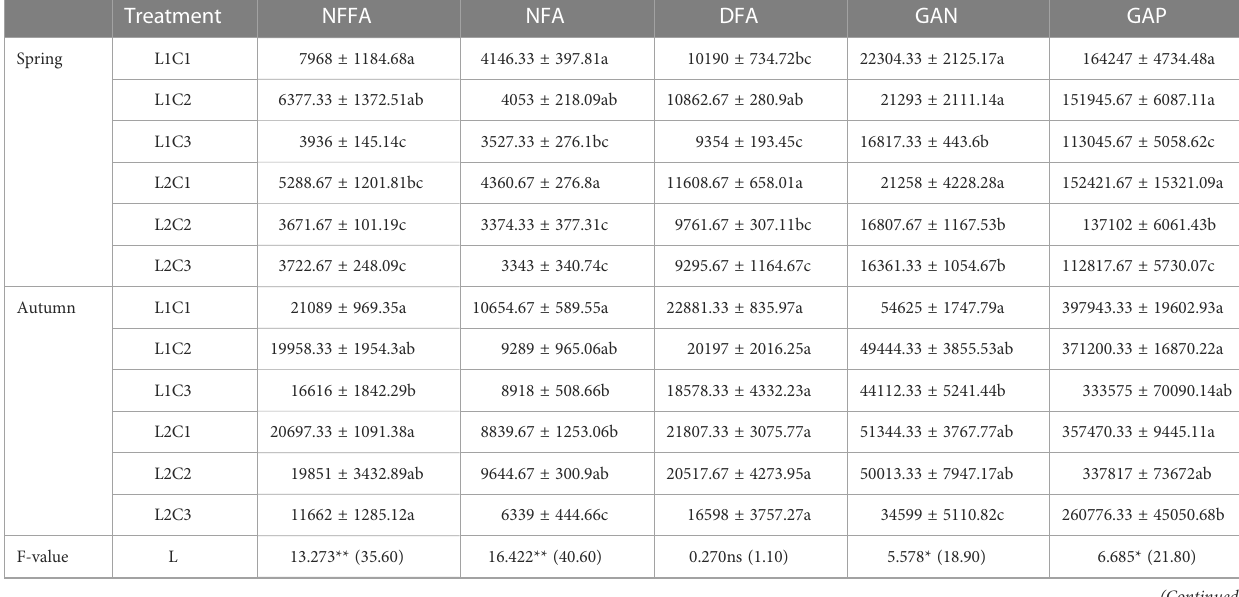
TABLE 4 Comparative analysis functional genes related to N and P metabolism of soil